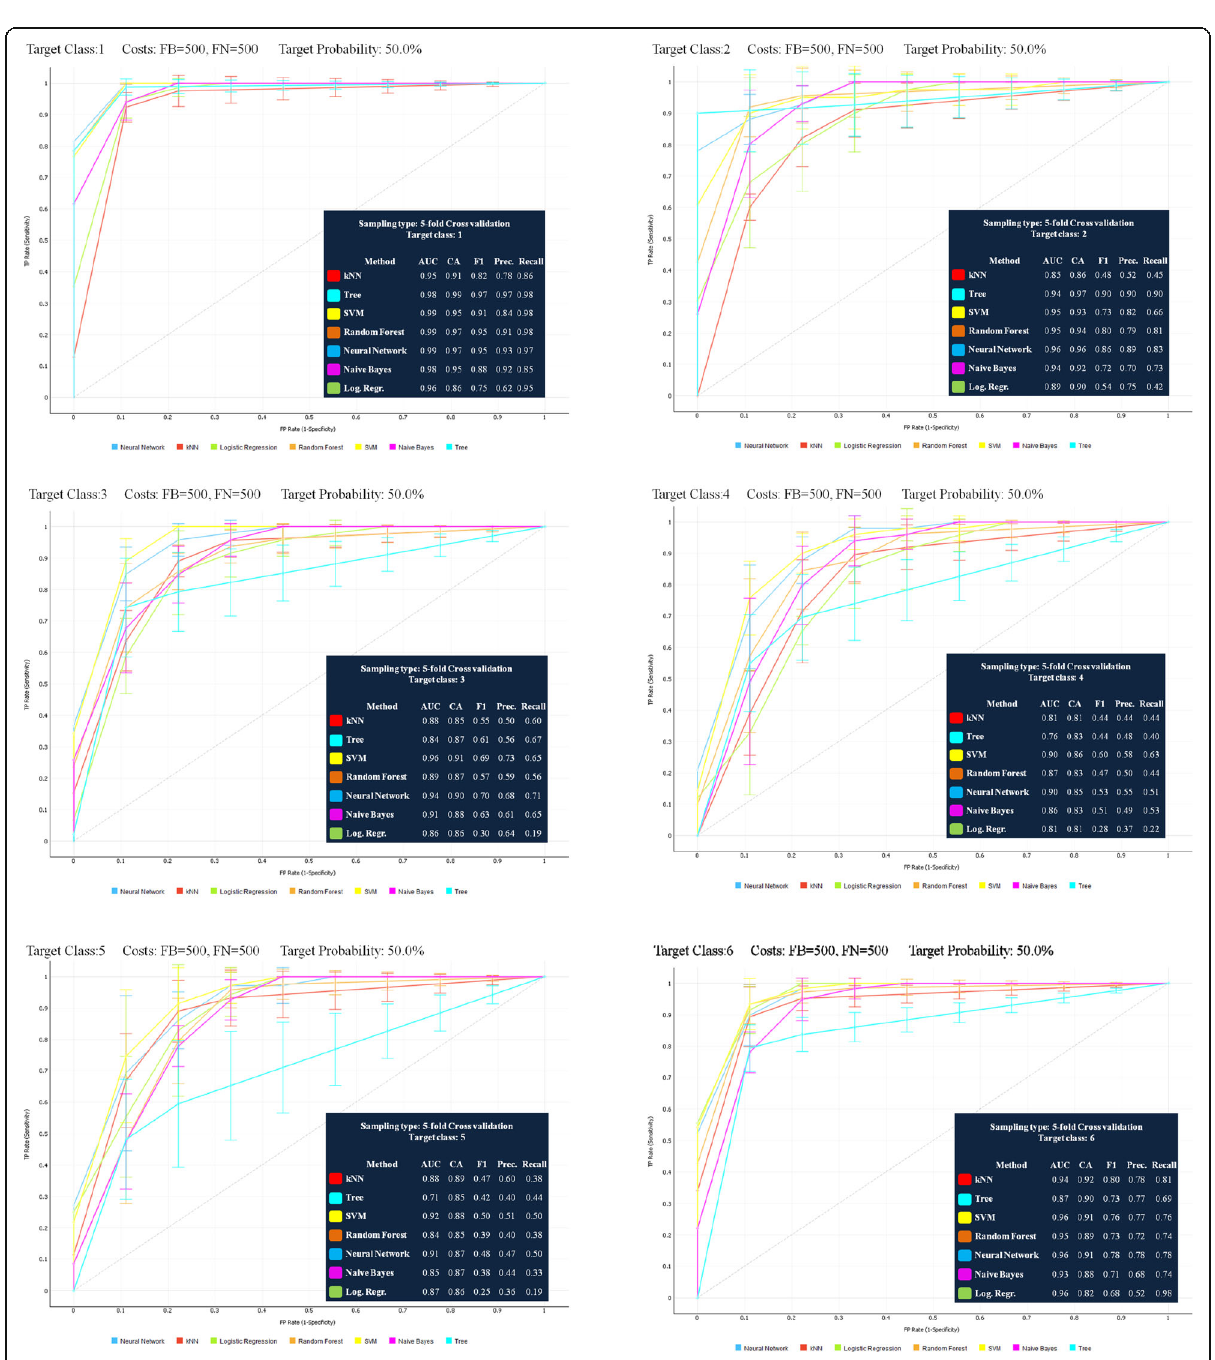
Fig. 4 The ROC curves of the algorithms used for determination of CVS and the tables of average test set classification accuracy (CA) results from five-fold